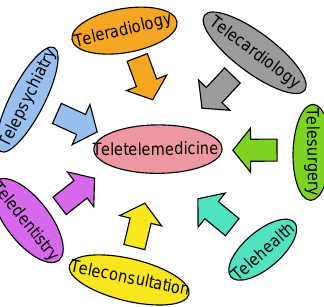
Figure 4. Branches of